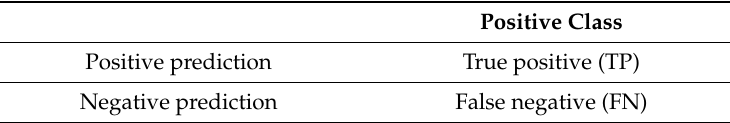
Table 2. Confusion